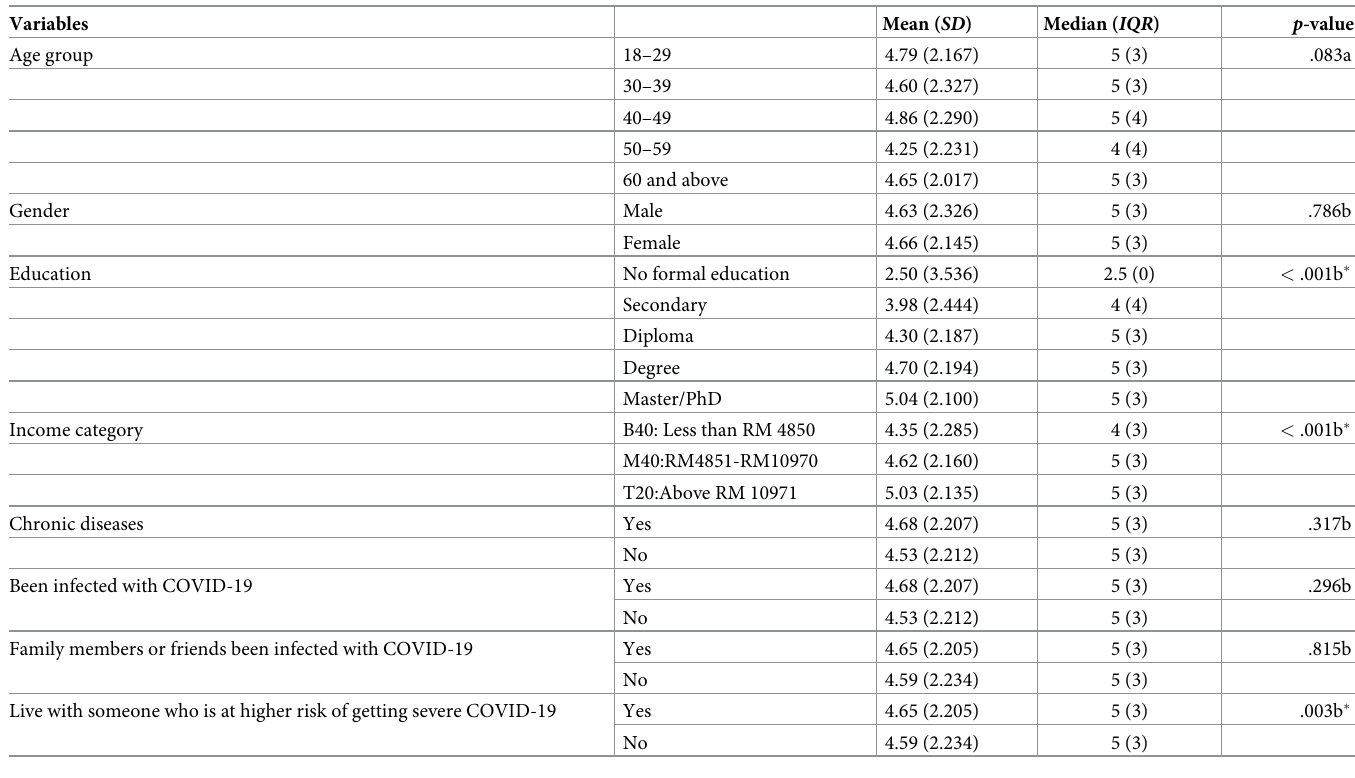
Table 3. Association between demographic factors and knowledge score (N = 1406).